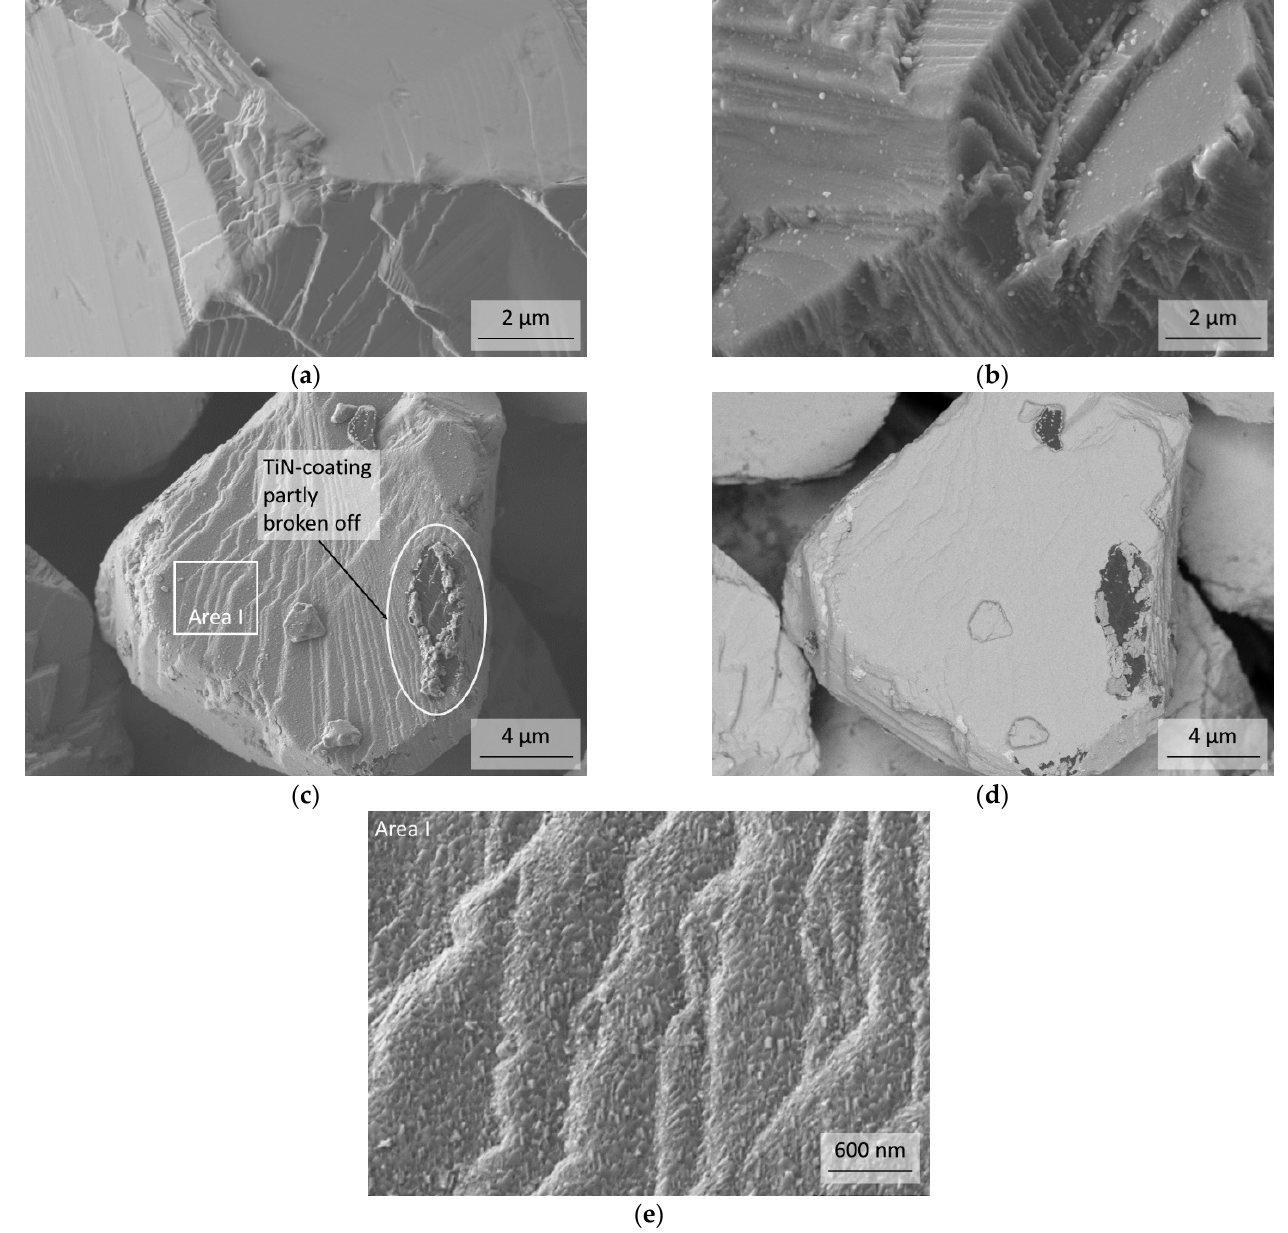
Figure 3. FESEM micrographs of uncoated cBN particles B21 ( a ) and coated with TiN BT ( b – e ) before the heat treatment. ( d ) same area as ( c ) with material contrast (energy selective backscattered electrons (ESB)-detector); ( e ) is a section (Area I) of micrograph ( c ) to reveal the microstructure of the TiN coating in more detail.